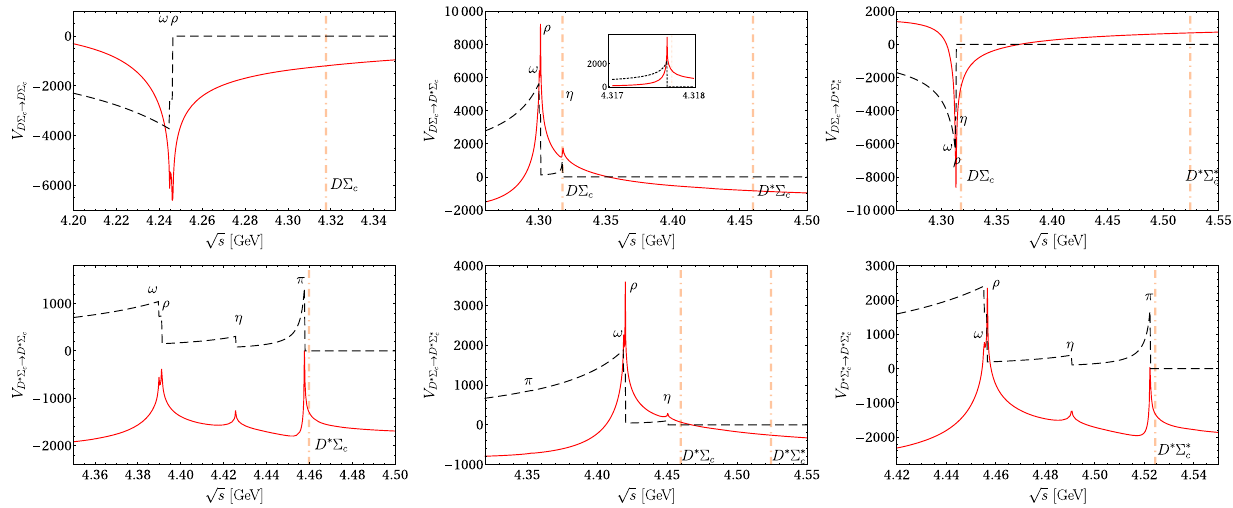
Fig. 5 V matrix for the S -wave D (cid:2) c - D ∗ (cid:2) c - D ∗ (cid:2) ∗ c coupled-channel system with ( I , J ) = ( 1 / 2 , 1 / 2 ) . For notations, see Fig. 3 Table 2 Pole positions obtained from the 5 / 2 − D ∗ (cid:2) ∗ c , 3 / 2 − D (cid:2) ∗ c - D ∗ (cid:2) c - D ∗ (cid:2) ∗ c and 1 / 2 − D (cid:2) c - D ∗ (cid:2) c - D ∗ (cid:2) ∗ c systems. The cutoff (cid:4) is varied in the range of (0 . 6, 0 . 8)GeV. All the pole positions are given in Channel 1 / 2 − 3 / 2